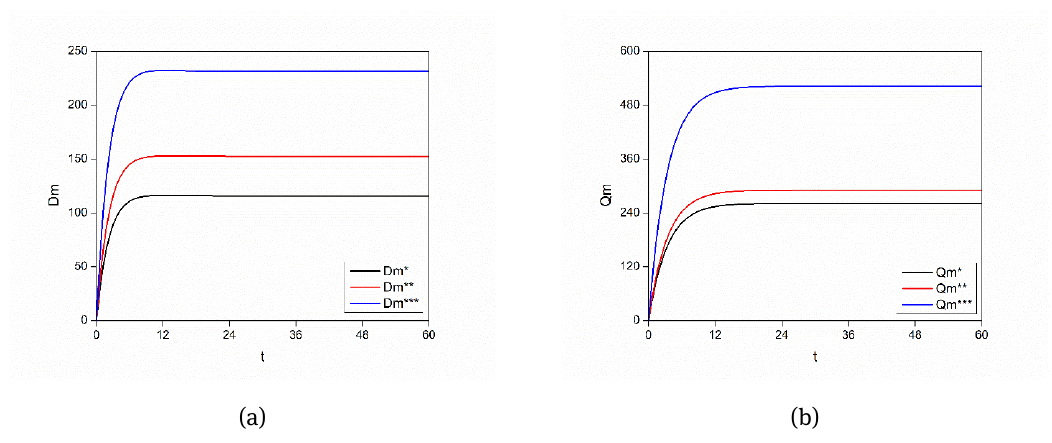
Figure 2: Change trend of manufacturer’s product green degree and